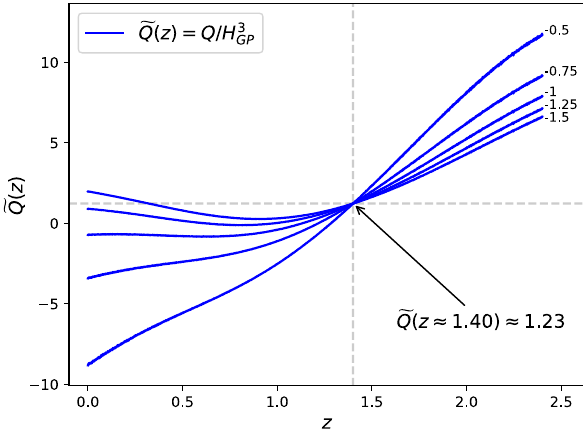
Fig. 3 Curves of (cid:24) Q ( z ) = Q / H 3 GP with five different w values, illus- trating the D-B point at the crossover. Each blue curve is (cid:24) Q ( z ) with w equals to the value noted at the top right. (cid:24) Q ( z ) is plotted here instead of Q ( z ) to avoid curves being hard to distinguish at the lower value region. Each Q ( z ) is reconstructed via GP and MCMC from OHD (Table 1). And H GP ( z ) is the mean value of the reconstructed H ( z ) in Sect. 2.2. The gray dashed horizontal and vertical lines meet at the D-B point, which corresponds to z ≈ 1 . 40 and Q ( z D-B ) ≈ 1 . 23 H 3 GP ( z D-B )